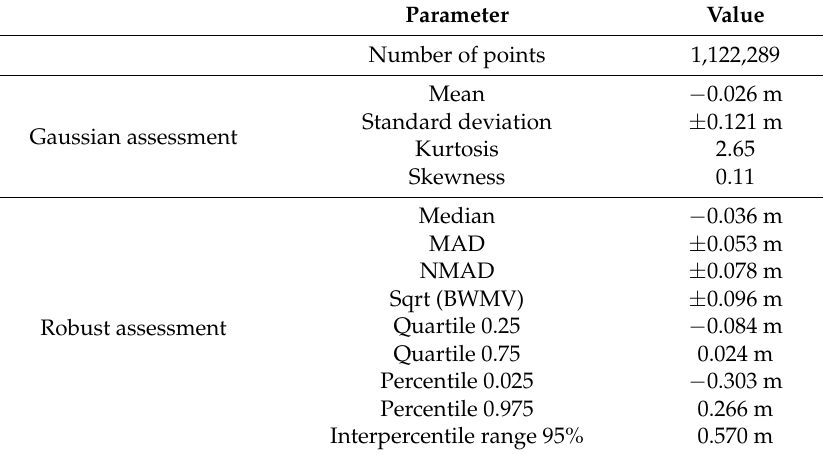
Table 4. Statistical results of the anastylosis process for the current remains. Adapted from [1]. BWMV: biweight midvariance, MAD: median absolute deviation, NMAD: normalized median absolute